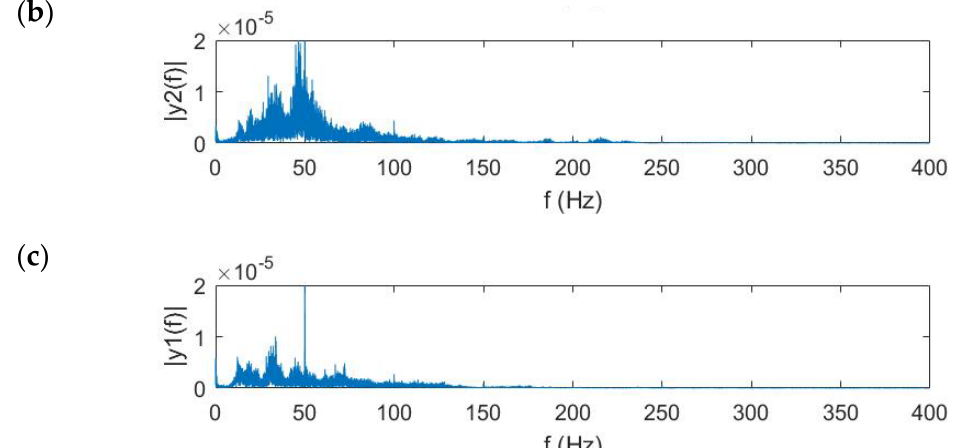
Figure 8. Frequency domain vibrational velocity on the ground measured at the distances from the leak of ( a ) 0.5 m, ( b ) 1 m, and ( c ) 1.5 m.